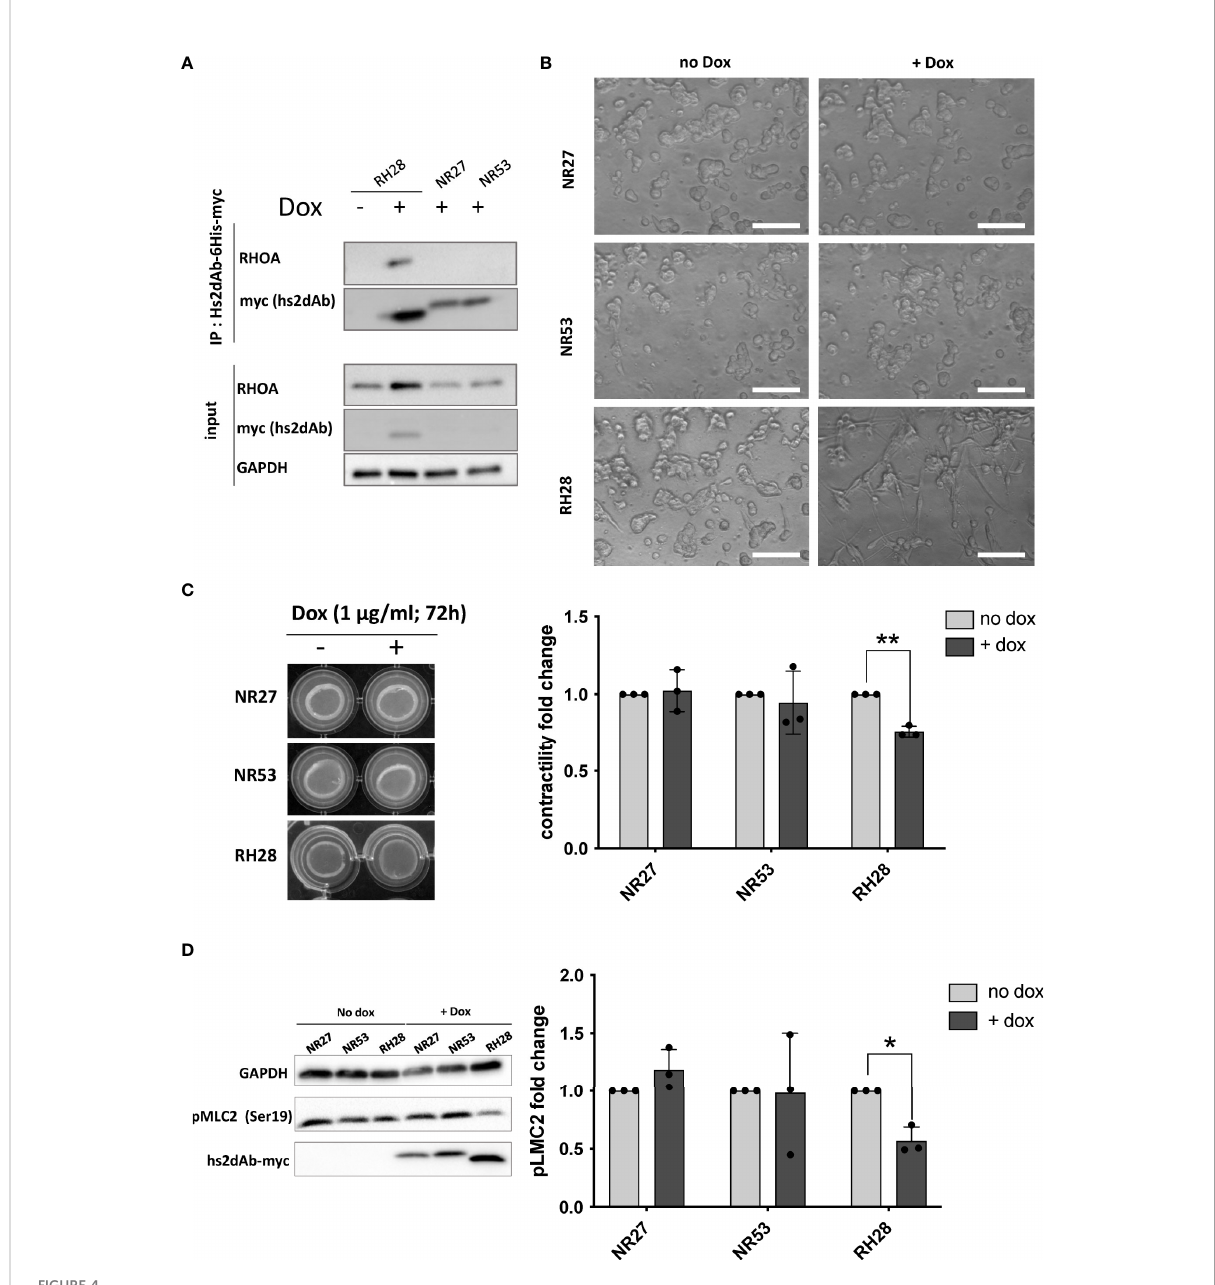
FIGURE 4 RH28 intrabody ef fi ciently inhibits actomyosin contractility and blocks RHOA/ROCK pathway in melanoma cancer cells. (A) RH28 selectivity validation in WM266.4 lentiviral cell line. Expression of RH28 and NR-hs2dAb was induced or not with doxycycline at 1µg/ml. After 20 hours of induction, cells were harvested and cleared cell lysates were incubated with Ni-NTA beads for 45 min. Endogenous RHOA proteins was revealed with corresponding antibodies and hs2dAb were revealed with myc-tag antibody. (B) Representative images of cell line morphology in 3D collagen drops after 6 hours of hs2dAb expression. WM266.4 cell lines were seeded in collagen and phenotypes were analyzed 24 hours post doxycycline induction. At 40X magni fi cation, elongated or rounded cell shape could be observed. Scale bar: 50 µm. (C) Representative images and quanti fi cation of gel contraction after 72 hours of treatment by doxycycline. (D) Representative immunoblot and quanti fi cation analysis of myosin light chain phosphorylation (pMLC2) status in the 3 different cell lines seeded in collagen drops. P-values were calculated using a Student ’ s t test.*p<0.05;